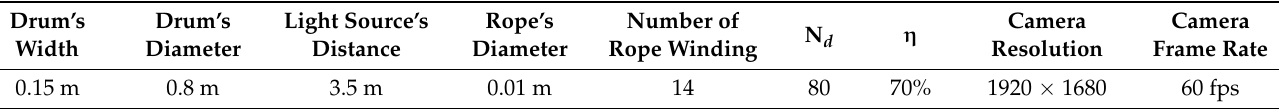
Table 6. The specific parameters of experiments in the ultra-deep well simulation test bench.